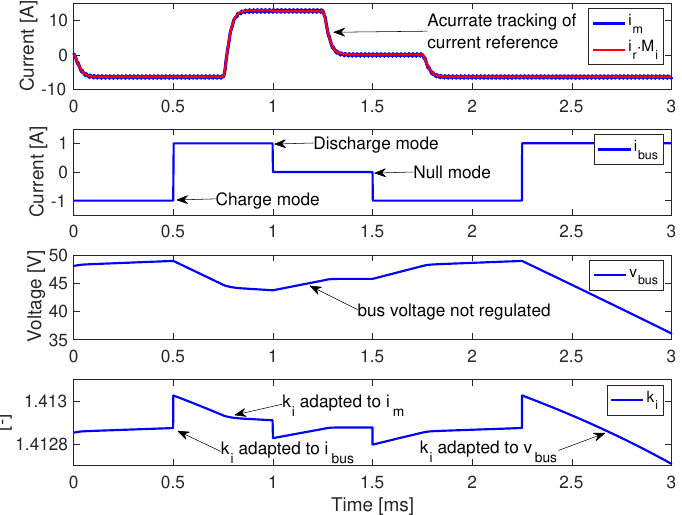
Figure 7. Circuital simulation of the adaptive current loop in PSIM for arbitrary values of i r